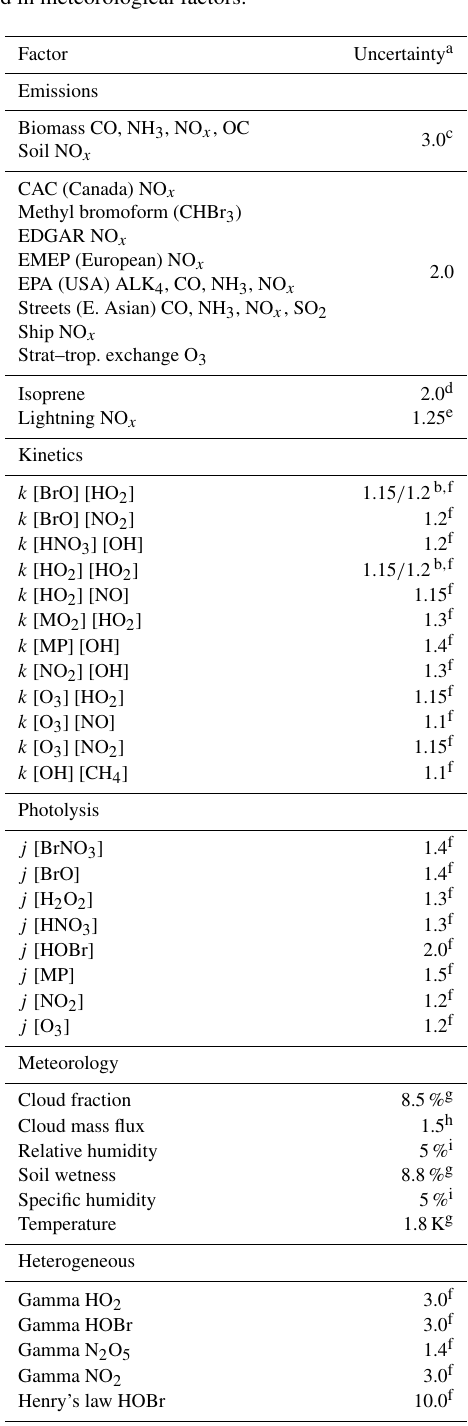
Table 1. Factors included in RS-HDMR analysis and their respec- tive uncertainties. OC is organic carbon, ALK 4 is lumped ≥ 4C alkanes, MP is methylhydroperoxide, and MO 2 is methylperoxy radical. Uncertainties are expressed as multiplicative factors, except as noted in meteorological